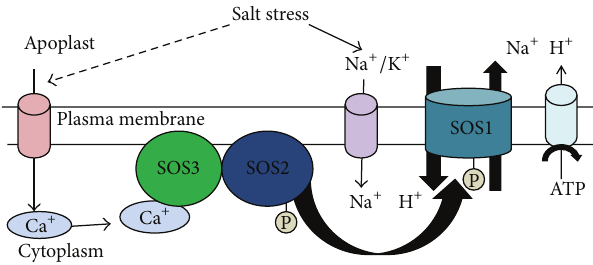
Figure 1: Model of SOS pathway for salinity stress